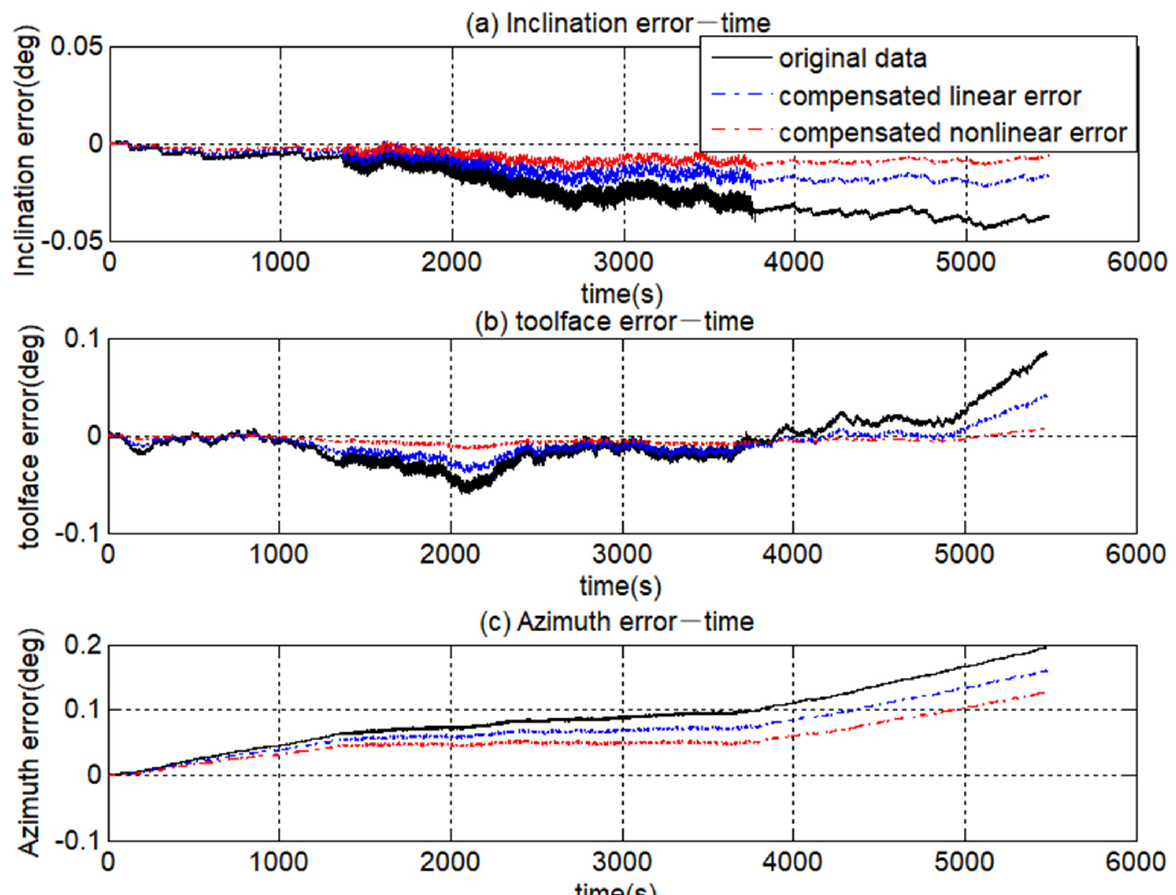
Figure 19. The attitude